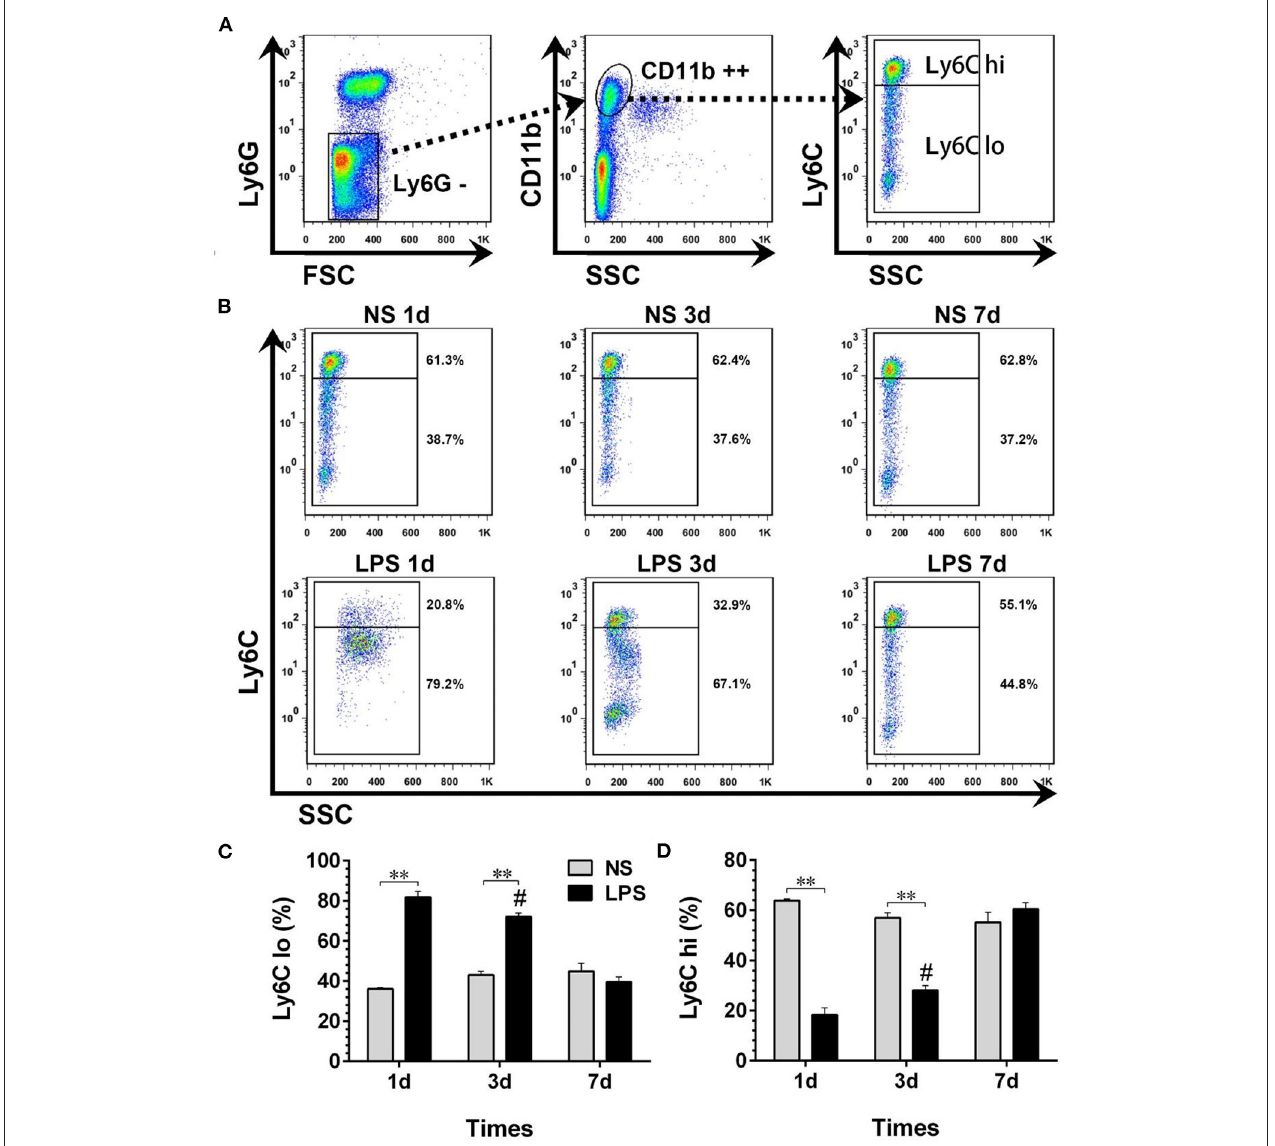
FIGURE 4 | Temporal dynamic changes of peripheral circulating monocyte subpopulations after LPS stimulation. (A, B) Ly6C hi and Ly6C lo monocytes were identified by flow cytometry. Numbers outside boxed areas indicated the percentage of cells. The gating strategies for peripheral circulating monocyte subpopulations are shown in (A) . The dynamic characteristics of Ly6C hi and Ly6C lo monocytes in NS and LPS groups are shown in (B) . (C, D) Kinetics of increase in Ly6C hi and Ly6C lo monocyte numbers in peripheral blood. FSC, forward-scattered light; SSC, side-scattered light. # p < 0.05, compared with the LPS group on day 1; ** p < 0.01. ( n = 5 in each